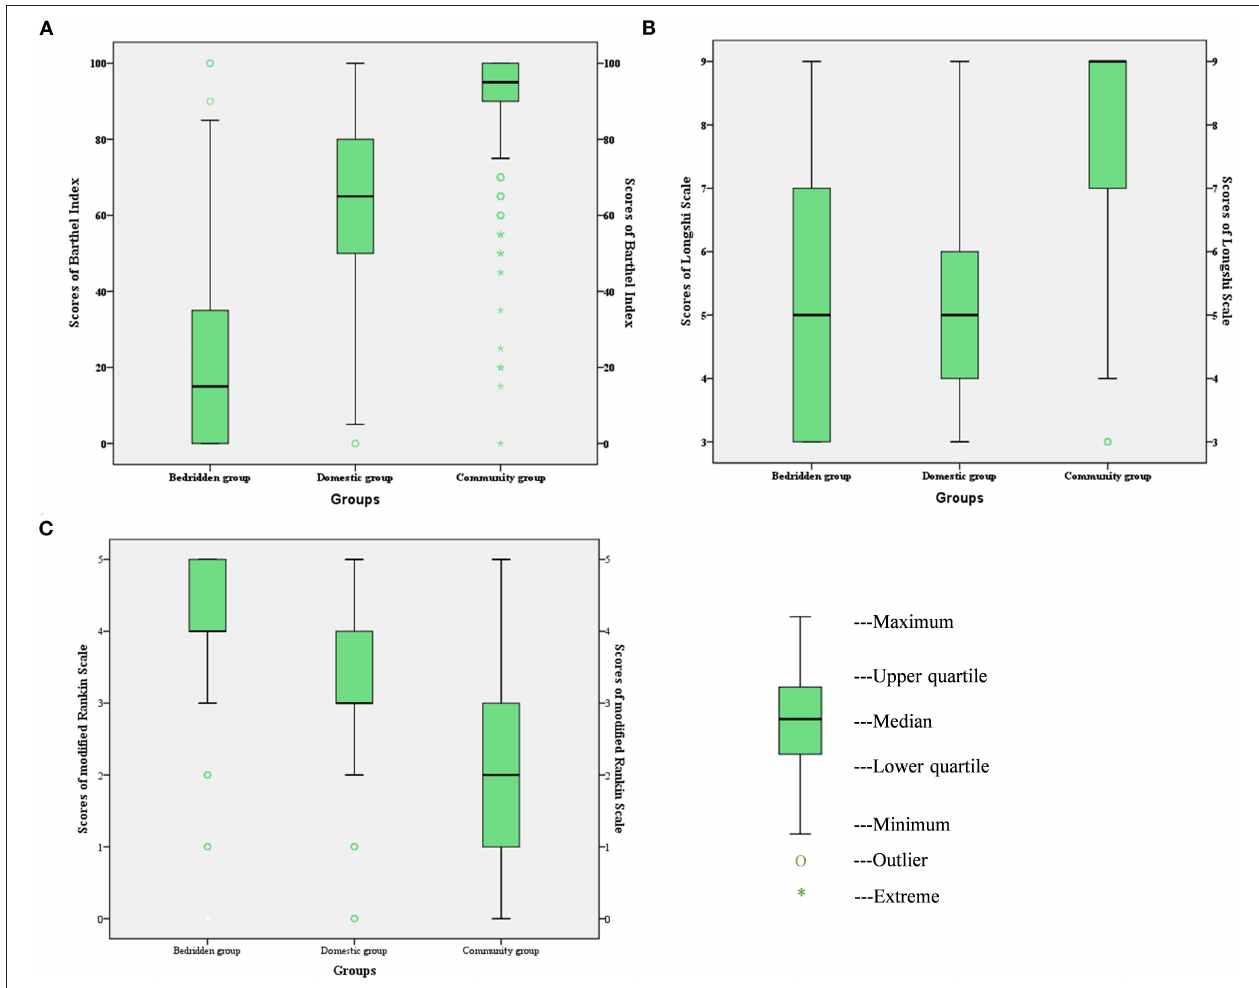
FIGURE 2 | Distribution of BI scores (A) , LS scores (B) , and mRS scores (C) in the bedridden group, domestic group and community group. BI, Barthel Index; LS, Longshi Scale; mRS, modified Rankin Scale.